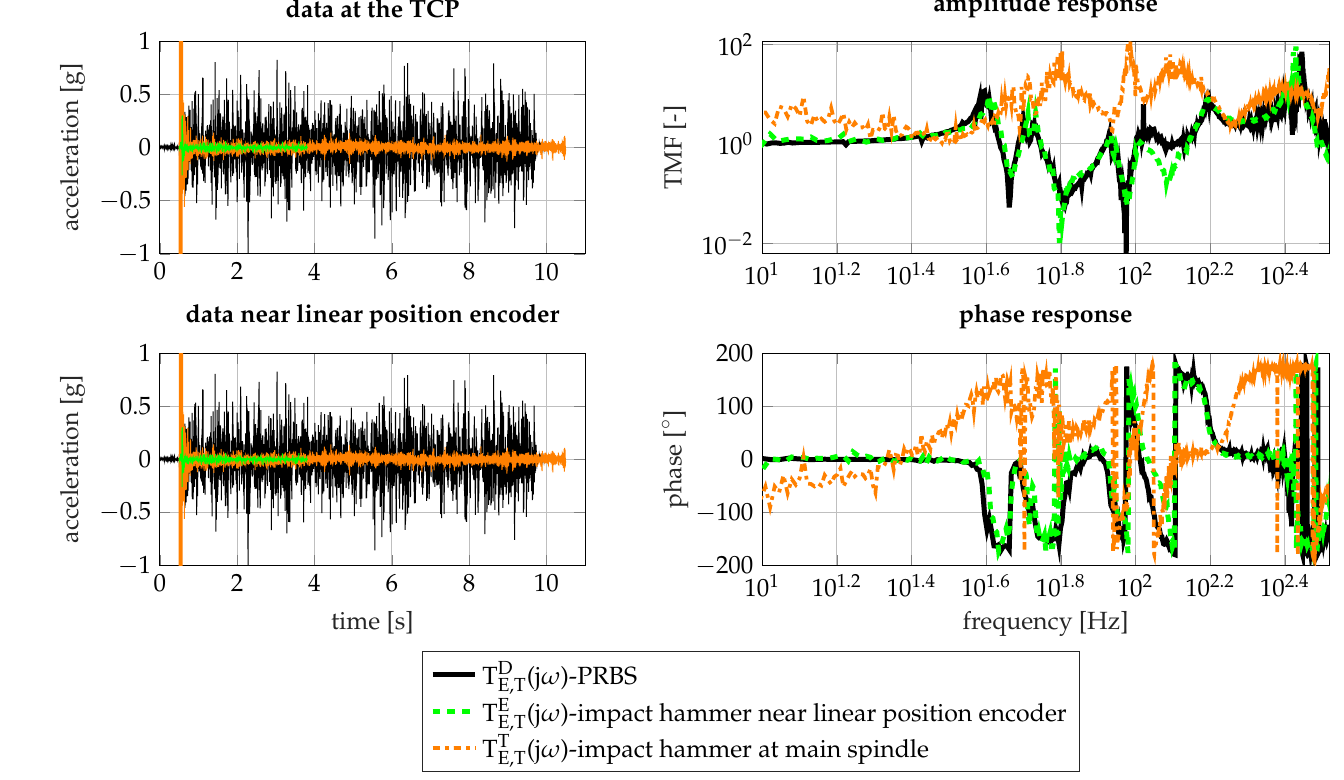
Figure 4. TMF for different points of excitation (experimental